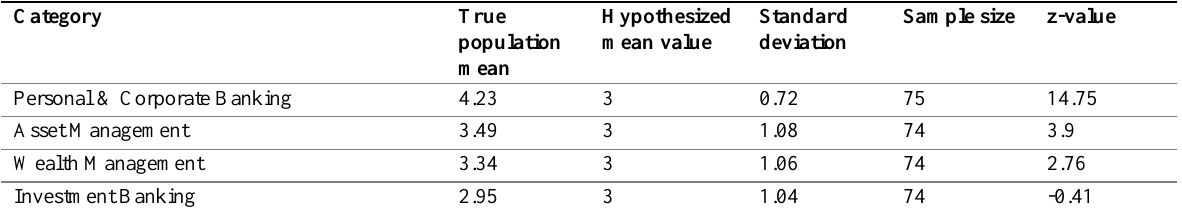
to digital disruption